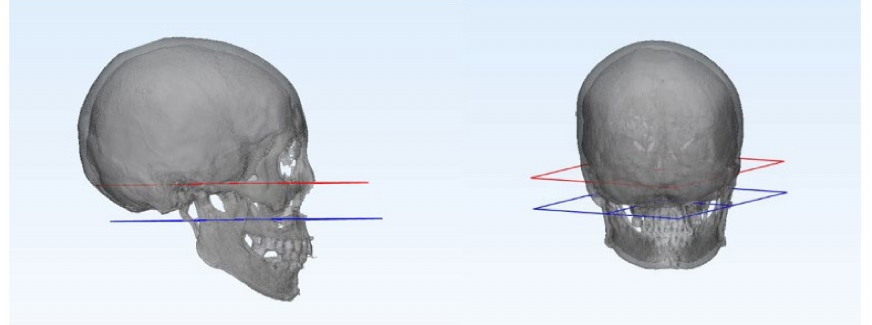
Figure 6. The red plane indicates the FH-plane, orbitale to porion. The blue plane is parallel to the FH-plane and passes through the posterior point of the subcondylar fracture